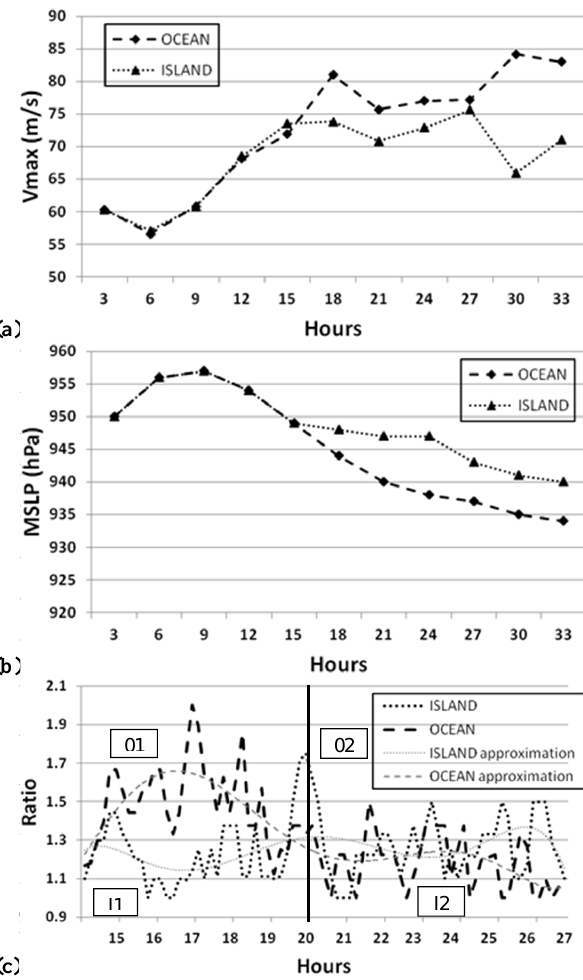
Fig. 6. (a) Observed Doppler velocity values (ms − 1 ) at 0.5 ◦ eleva- tion at 14:22UTC on 22 January 2002; (b) Doppler velocity values (ms − 1 ) deduced from the “ Island ” experiment at 17:30 at 1000m altitude. Symbol “R” indicates the location of the Doppler radar, the dashed line contour indicates the location of R´eunion island, nega- tive values (away from the radar) are